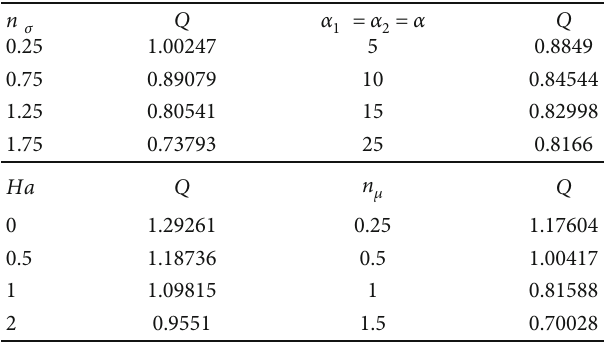
Table 5: Variation of shear wall stress Darcy number ( Da ) and density ratio ( n ρ at the lower plate ð τ xy 1 Þ and at the upper plate ð ) τ Þ xy 2